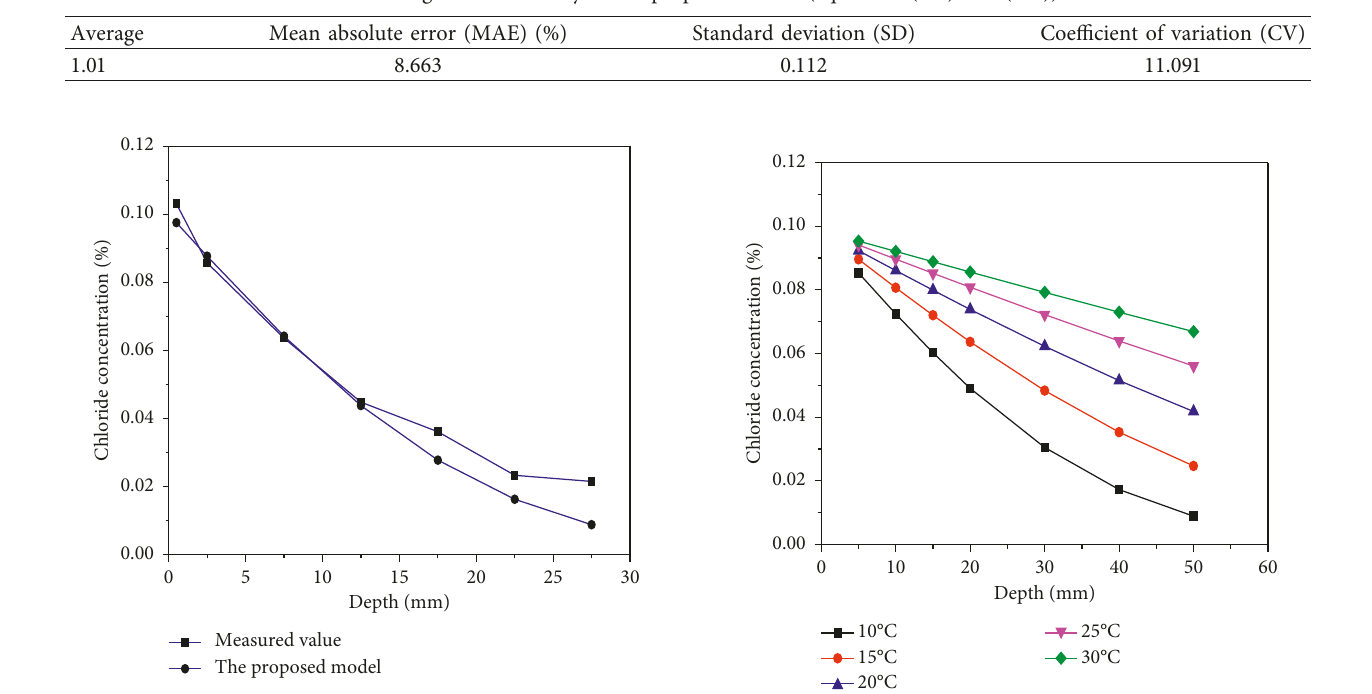
Figure 7: Chloride profile vs. ambient temperature according to the proposed model (equations (14a) and